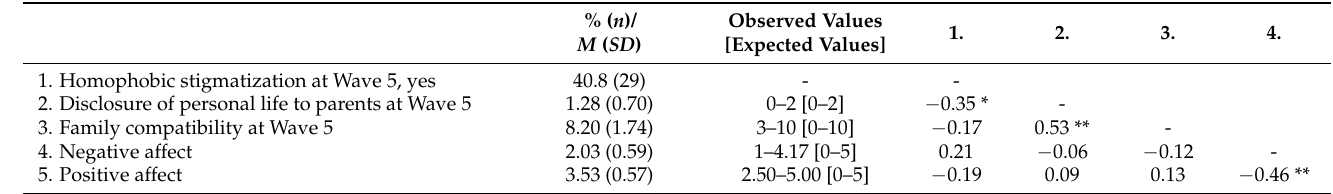
Table 2. Percentage ( n ), means ( M ), standard deviations ( SD ), observed and expected values, and intercorrelations on the studied variables (N = 71).